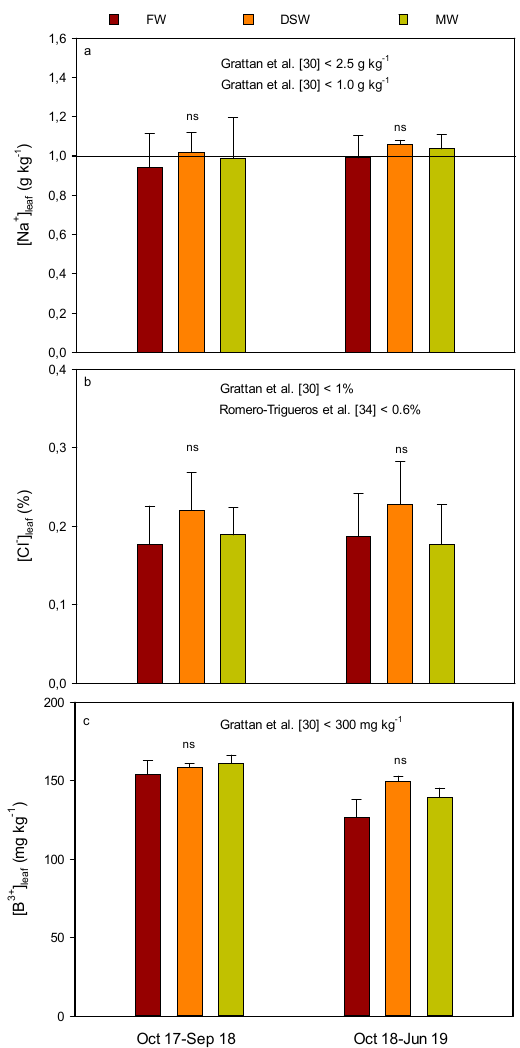
Figure 3. Mean leaf concentrations and standard deviations of ( a ) Na + , ( b ) Cl − , and ( c ) B 3 + for the periods from October 2017 to September 2018 and from October 2018 to June 2019 for the three irrigation treatments (fresh water; FW, desalinated sea water; DSW, and mixed water; MW). ns means that significant di ff erences were not detected among the treatments for each period (P ≤ 0.05). References in the figures represent toxic thresholds found for